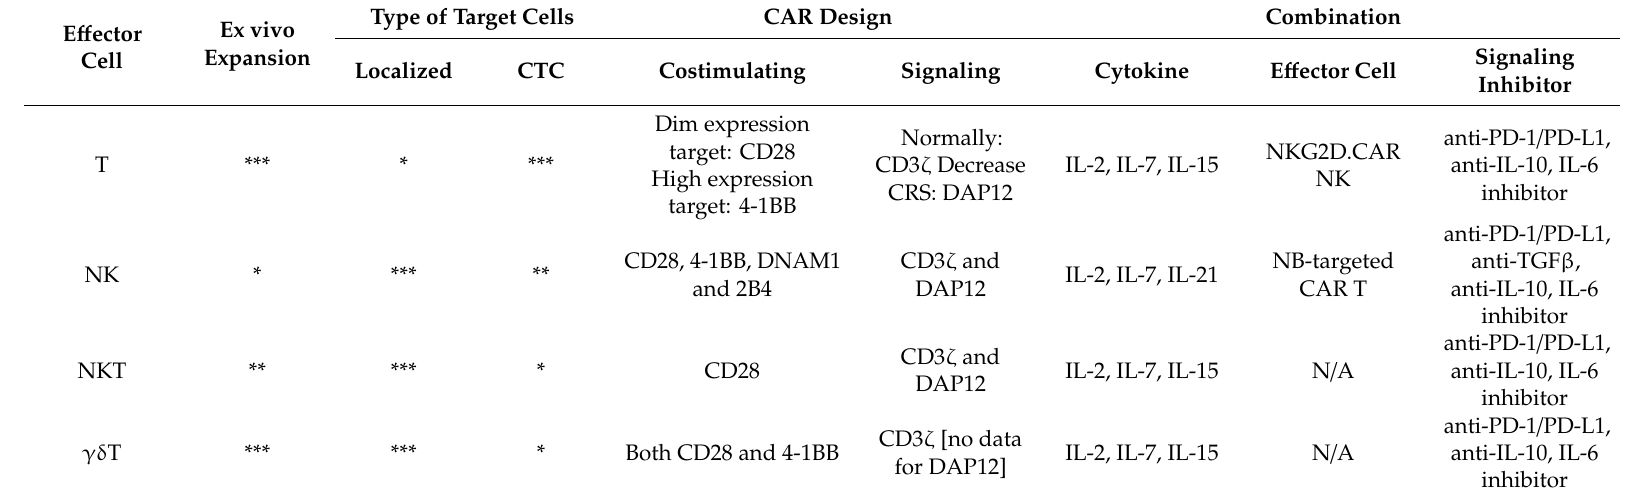
Table 2. Comparison of CAR-derived e ff ector cells for